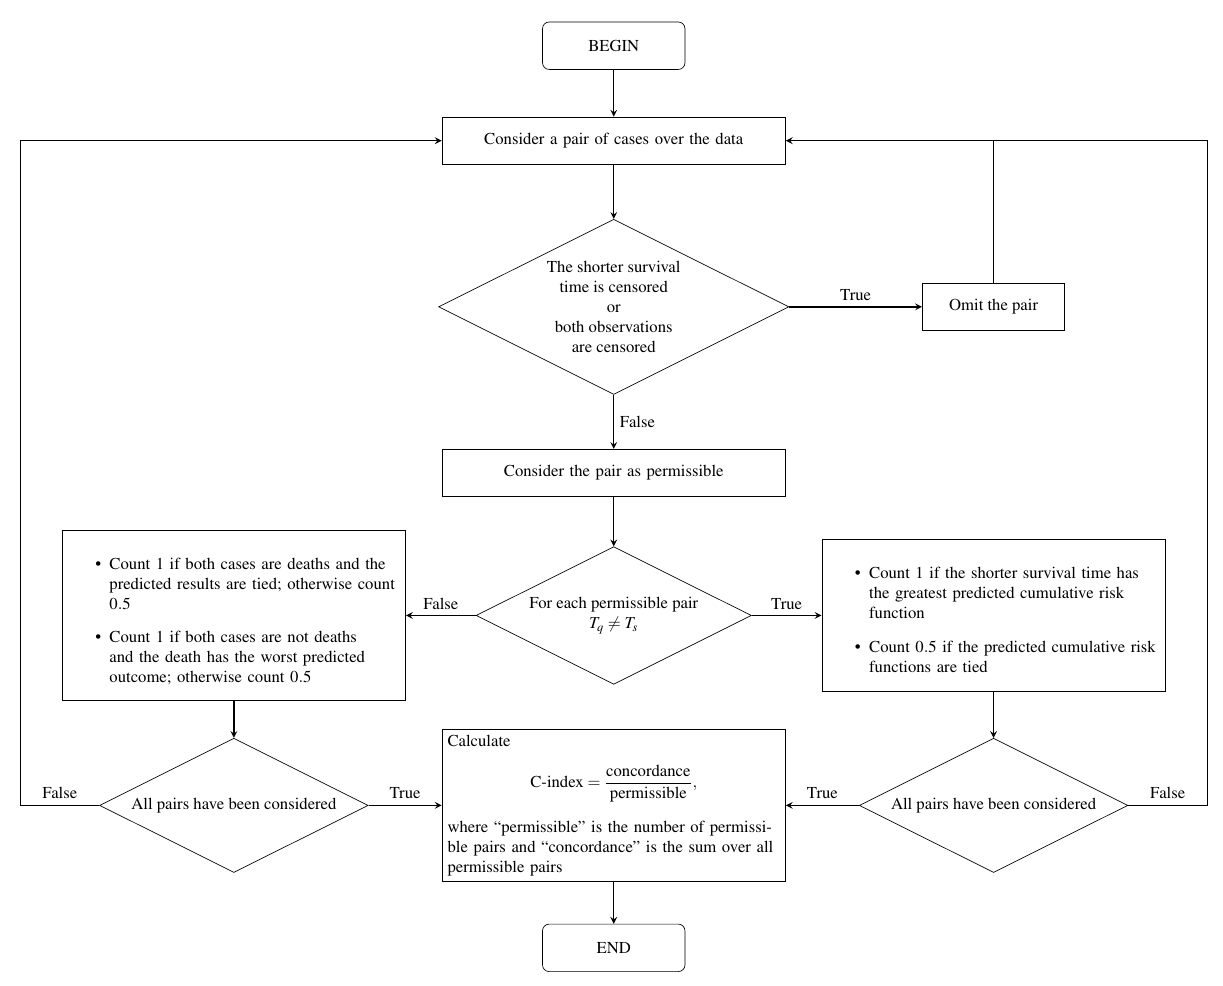
Figure 2. Flow diagram of the C-index computation based on